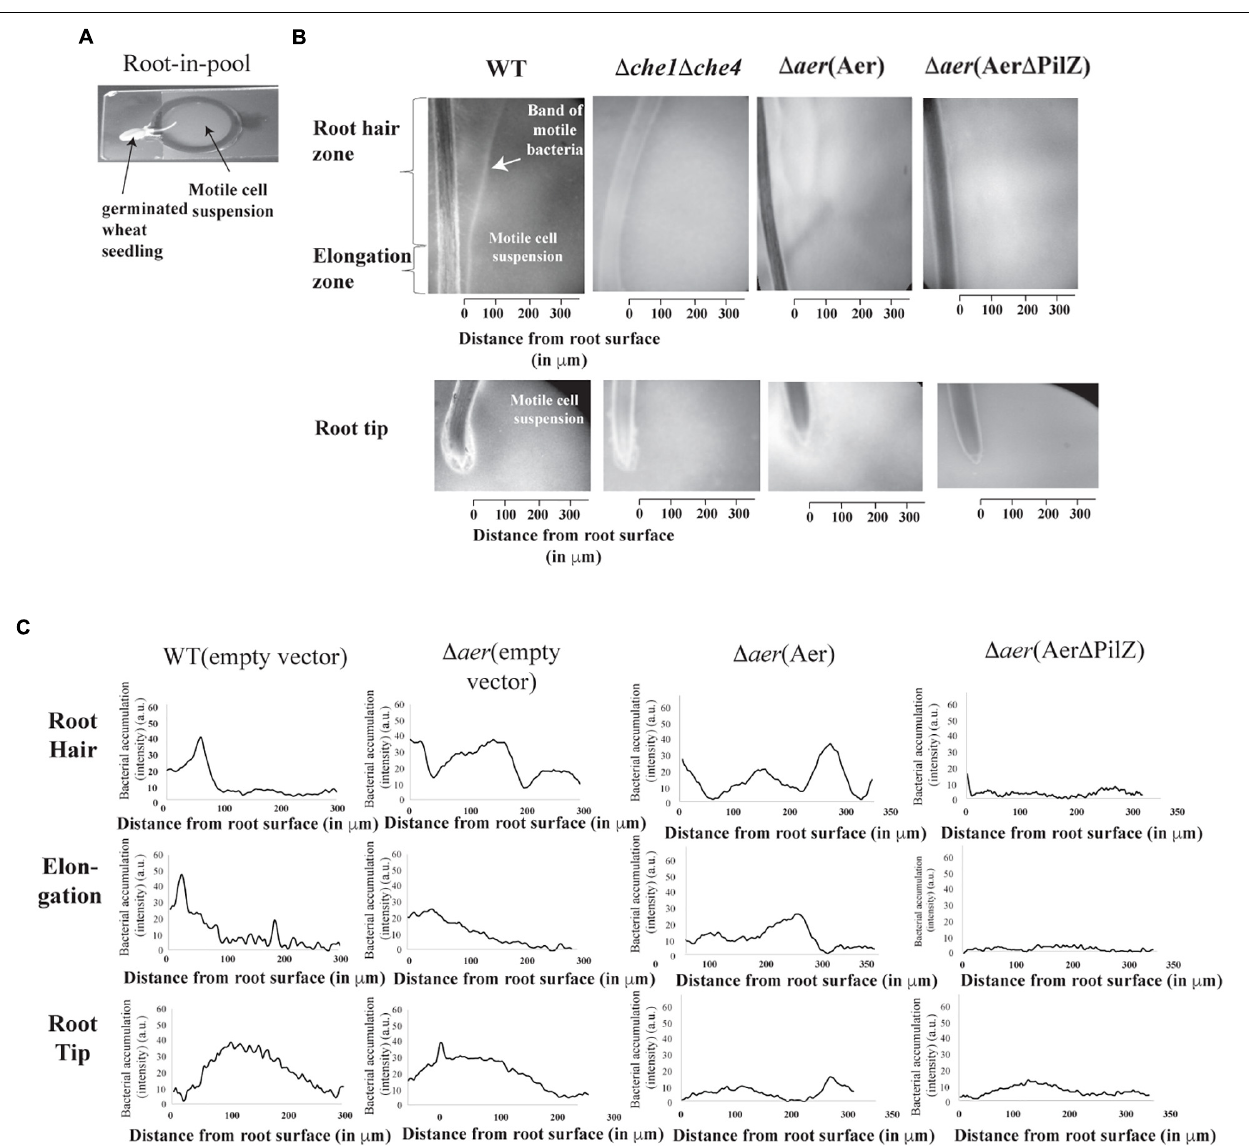
FIGURE 4 | A. brasilense accumulation around wheat roots using a root in pool assay. The root in pool consists of a divet slide with an attached O-ring. The pool of bacteria is placed in the O-ring and the root is dropped in. The cell-root suspension is covered with a coverslip and 4 × magnification on a phase contrast scope is used to film (A) . This set up allows for monitoring of bacteria-root interactions at the root hair, elongation and tip zones (B) . Bacterial cell accumulation (as image intensity in arbitrary units) away from root zones indicated in the different strains of A. brasilense (C) . Shown are representative image intensity plots (bacterial accumulation) of five biological replicates of the